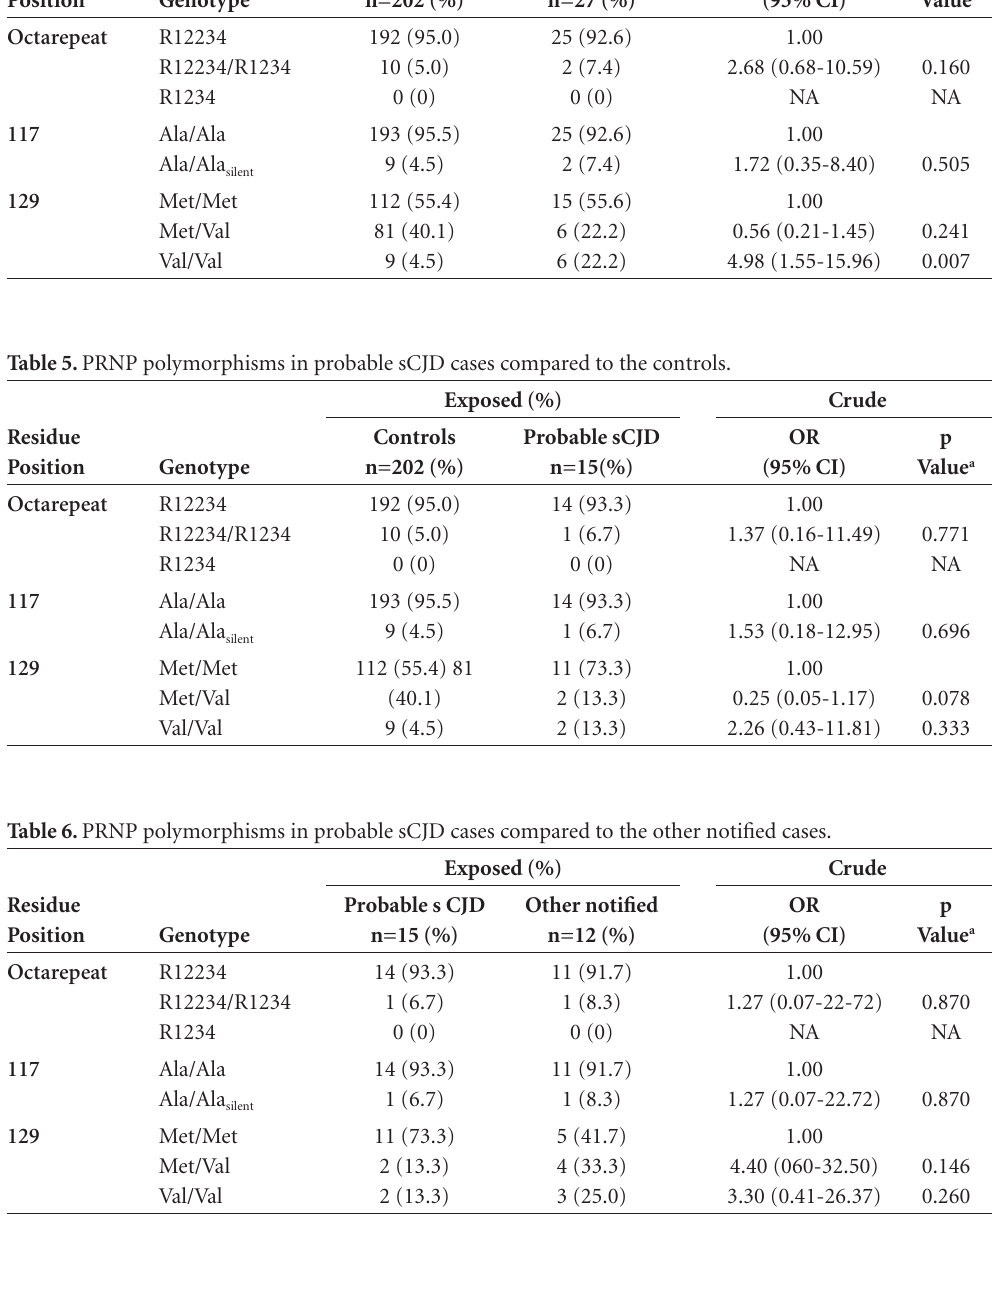
Table 4. PRNP polymorphisms in notified cases compared to controls. Residue